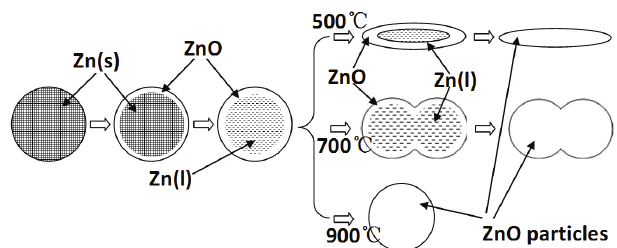
Figure 4. The growth mechanism of ZnO from Zn nanoparticles at different